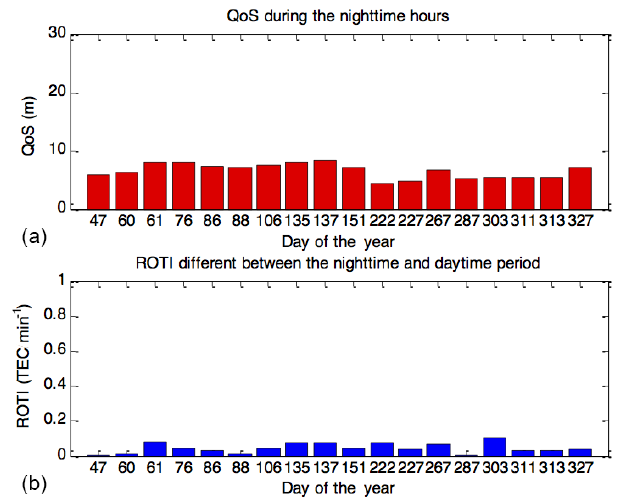
Figure 6. Summary of ionospheric irregularity-inhibited days with their correspondence SBAS